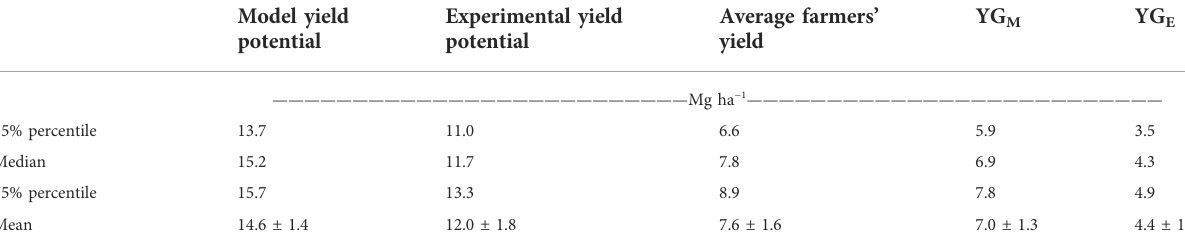
TABLE 1 Variability of the modeled yield potential, experimental yield potential, the average farmers ’ yields, YG M , and YGE among counties and factors contributing to variation for YG E . Model yield Experimental yield Average farmers ’ potential potential